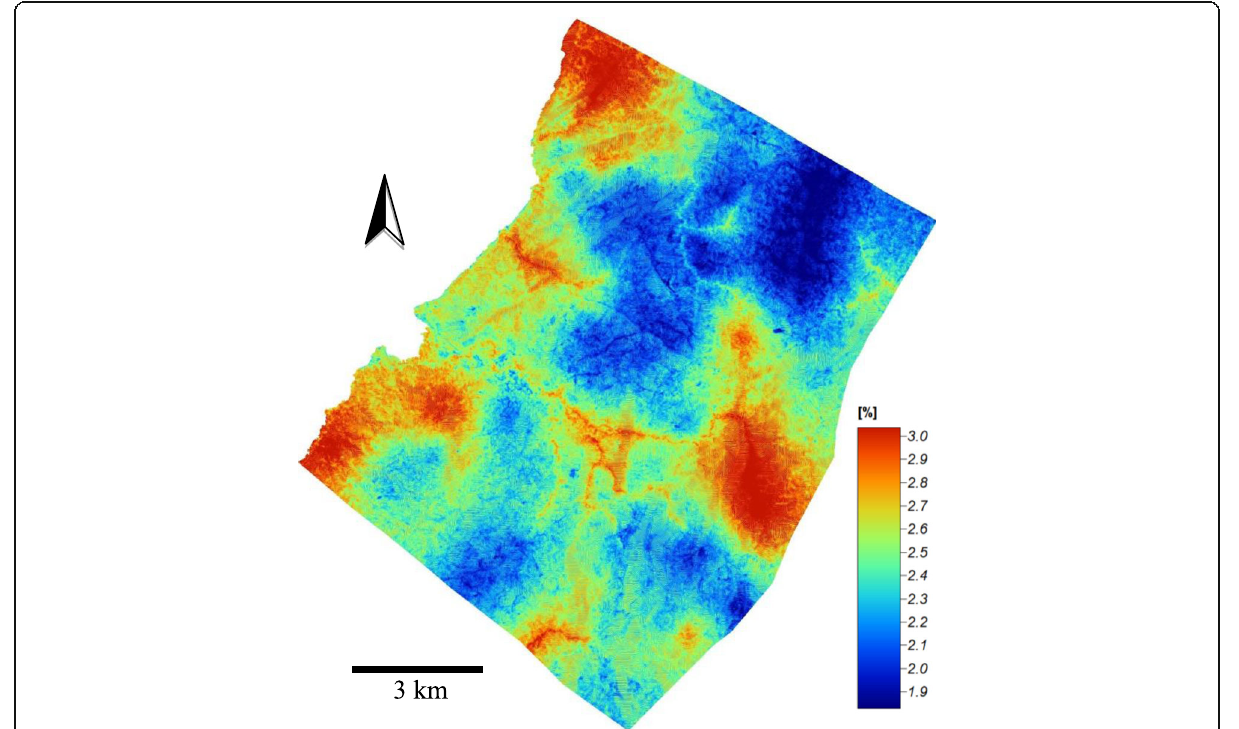
Fig. 9 Final Model of Transformed Sand by UK with predictors by backward elimination method and exponential